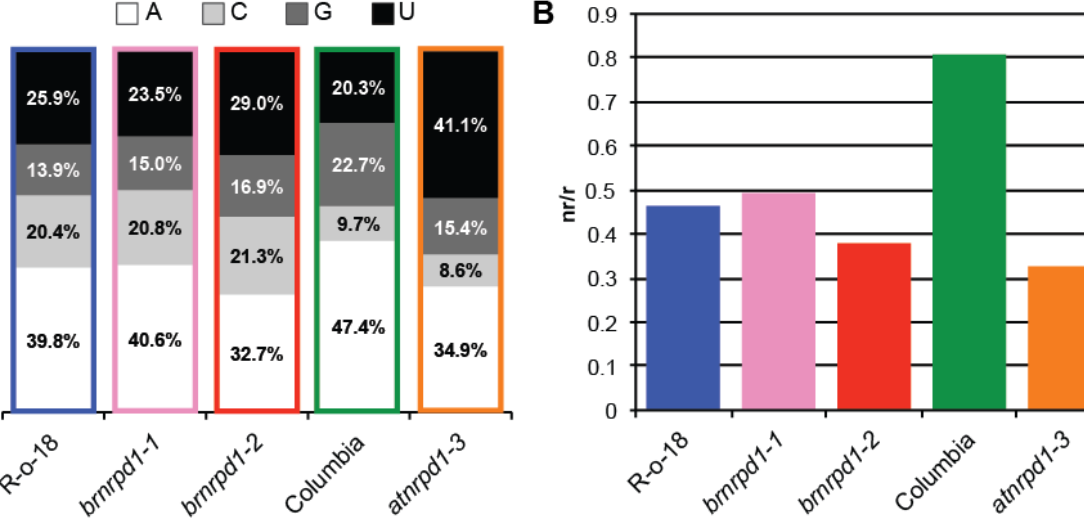
( a ) 5' nucleotide composition of sRNAs. ( b ) Complexity of sRNA populations as